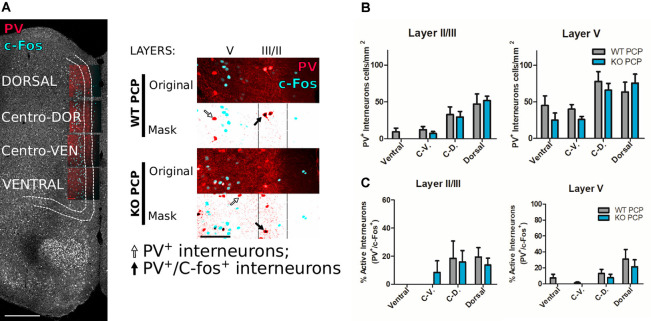
Medial prefrontal parvalbumin (PV) interneurons do not differ in terms of numbers and levels of activity in PCP-treated P2rx7−/− and P2rx7+/+ animals. (A) Examples of double immunostaining for c-Fos and PV. Reconstructed mPFC from a P2rx7+/+ phencyclidine (PCP) treated (WT PCP) mouse. Scale bar, 500 μm (left). Representative images of dorsal mPFC double immunostaining (right). The original pictures are the stacks maximal projections while masks are the correspondent threshold images, combined to facilitate the manual counting of PV+ interneurons (black arrow) and double PV+ and c-Fos+ (white arrow) interneurons in the II/III (80 μm) and V (320–350 μm) layers. Scale bar 100 μm. (B) Results of manual counting of PV+ interneurons concentrations in mPFC of PCP-treated animals. (C) Results of the manual counting of double-positive PV+ and c-Fos+ interneurons expressed as the percentage of the counted PV+ interneurons in the mPFC. N = 4 (WT PCP), N = 3 (KO PCP). Shown is mean ± SEM. Statistical analysis was performed with two-way ANOVA followed by Bonferroni’s posthoc test. Scoring: no significant differences, p value > 0.05.